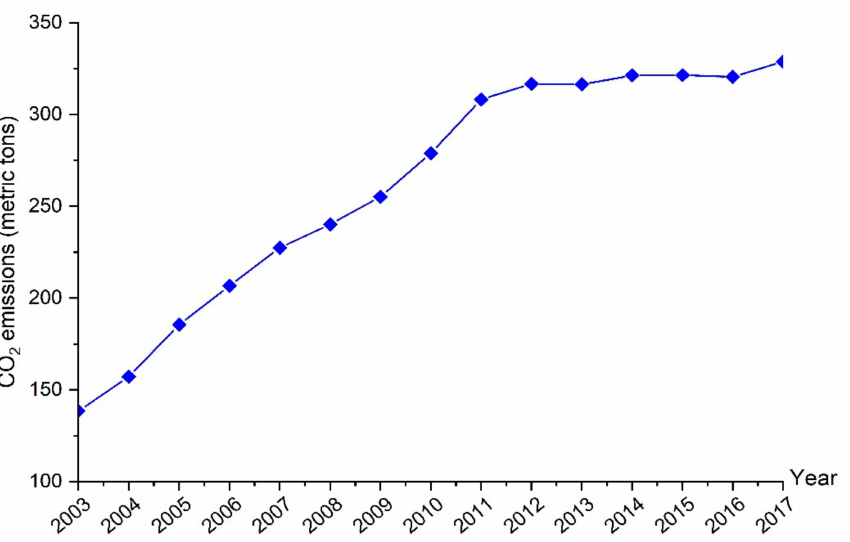
Figure 1. Annual trend of CO 2 emissions in China over 2003–2017. Data source: China energy statistical yearbook (https://data.cnki.net/Yearbook/ accessed on 16 June